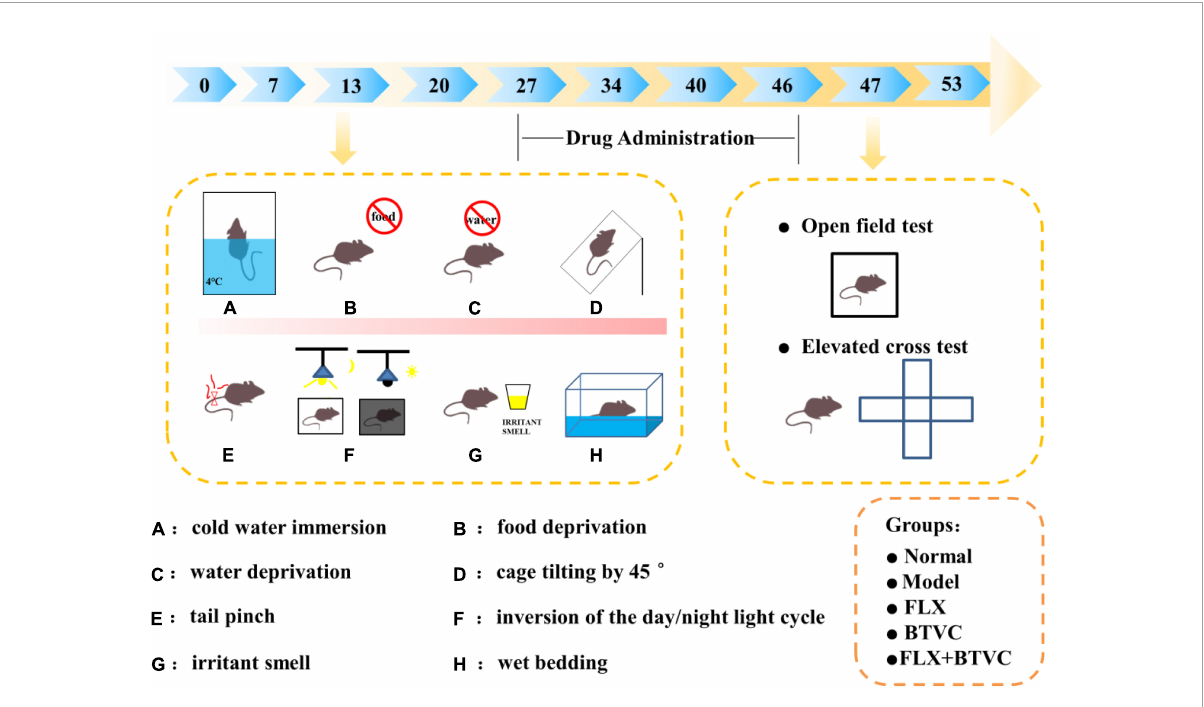
FIGURE1 The experimental timeline. (A–H) The CUMS procedure.